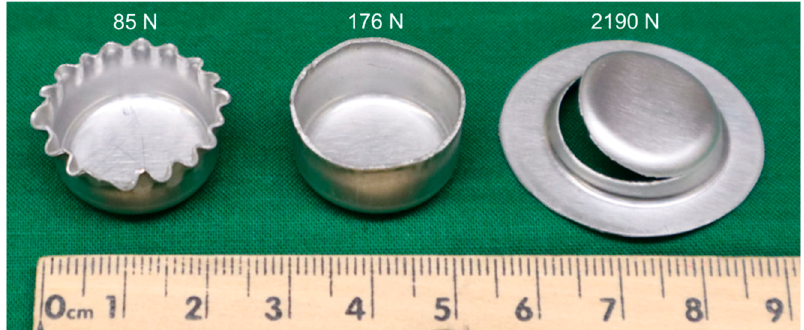
Figure 1. Aluminum AA1100-O cups drawn under different BHFs (from left to right: wrinkled (low BHF), fully drawn (medium BHF) and torn (high BHF)). The numbers listed are the BHFs.